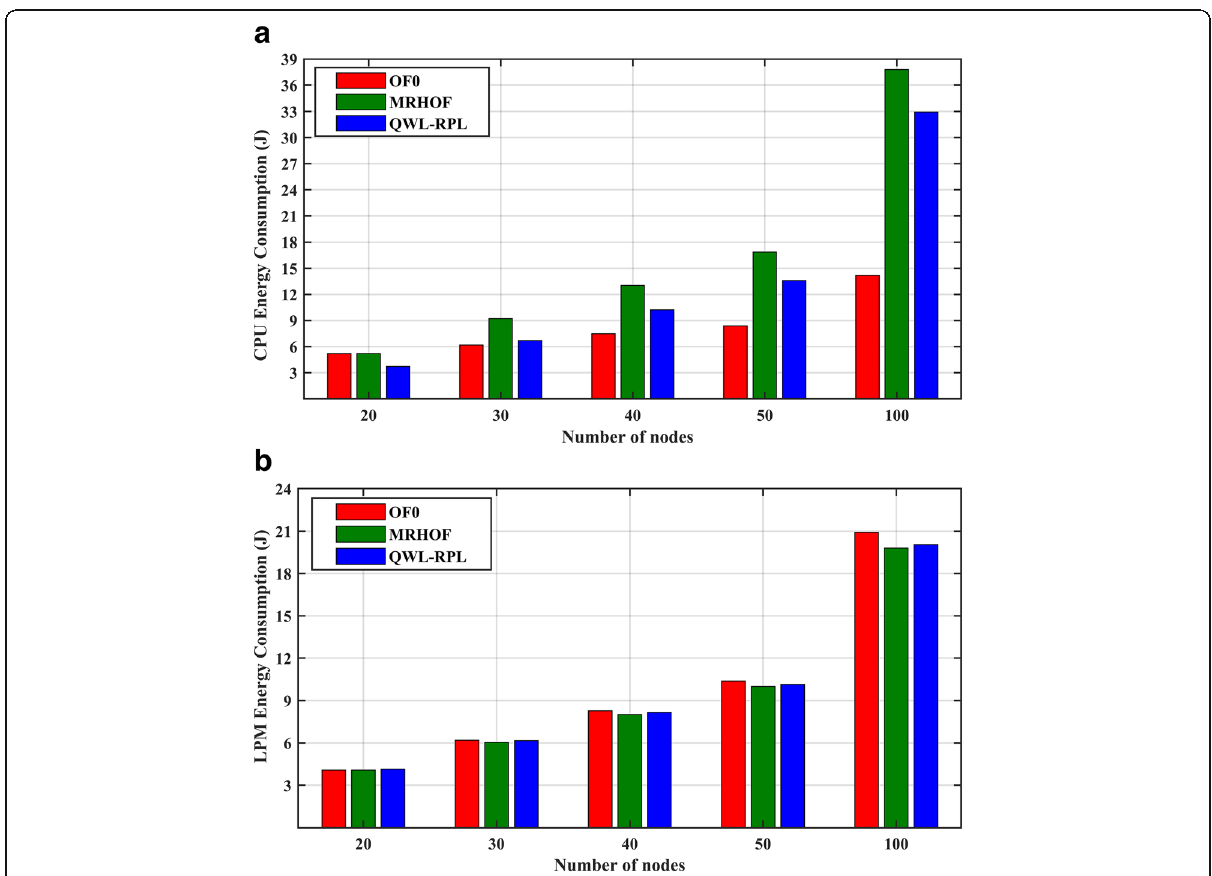
Fig. 17 Simulation analysis for scenario II for a CPU energy consumption (J) and b LPM energy consumption versus number of